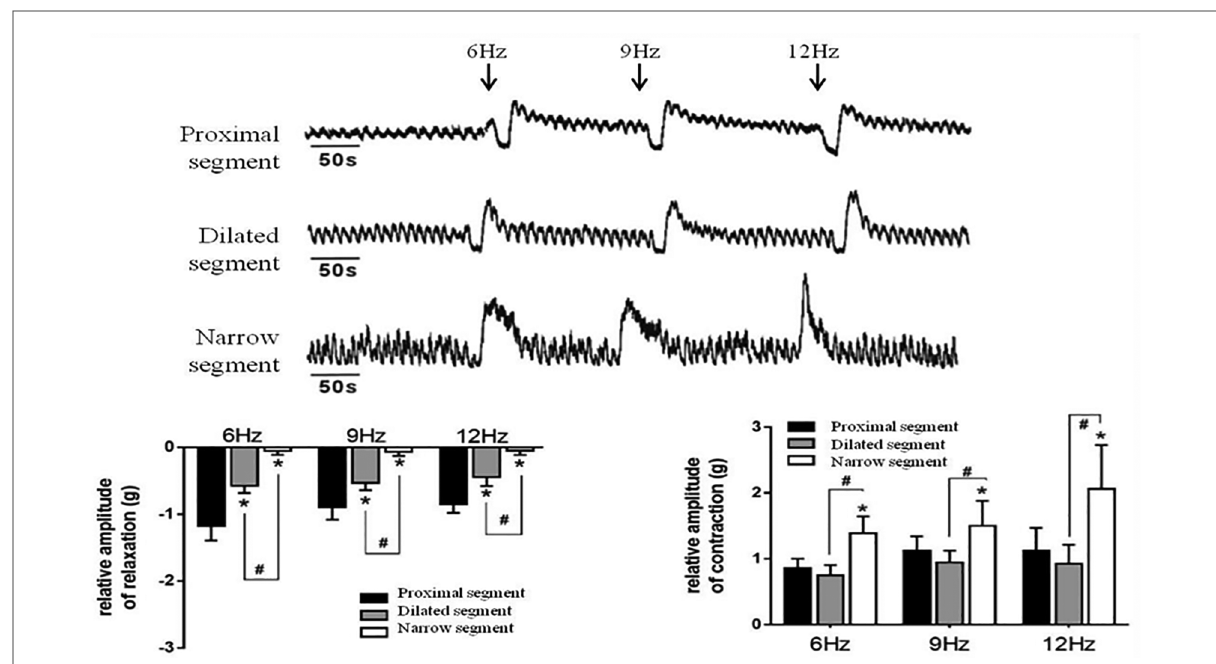
FIGURE 4 Effects of EFS-induced on smooth muscle contractions of the colon. Relaxation and subsequent contractile response after EFS in the proximal segment; relaxation response almost disappeared in the narrow segment. * P <0.05 vs. proximal segment; #<0.05 dilated vs. narrow segments.